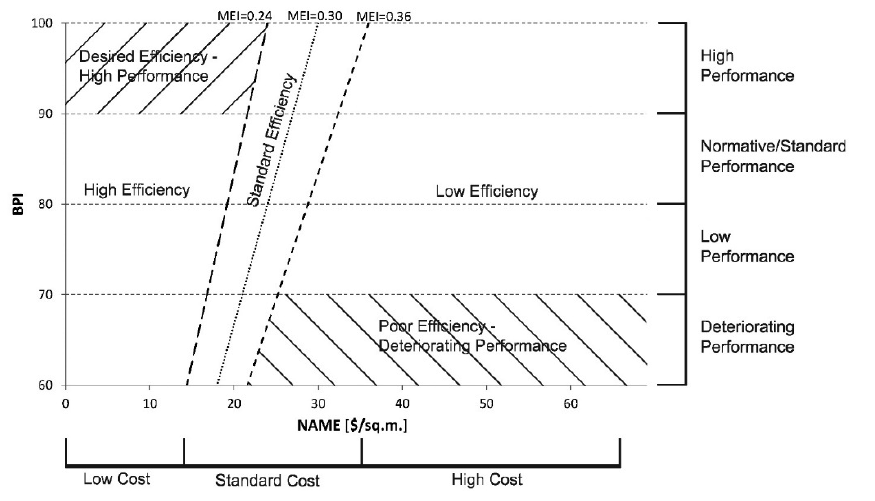
Fig. 2. MEI evaluation in terms of NAME -